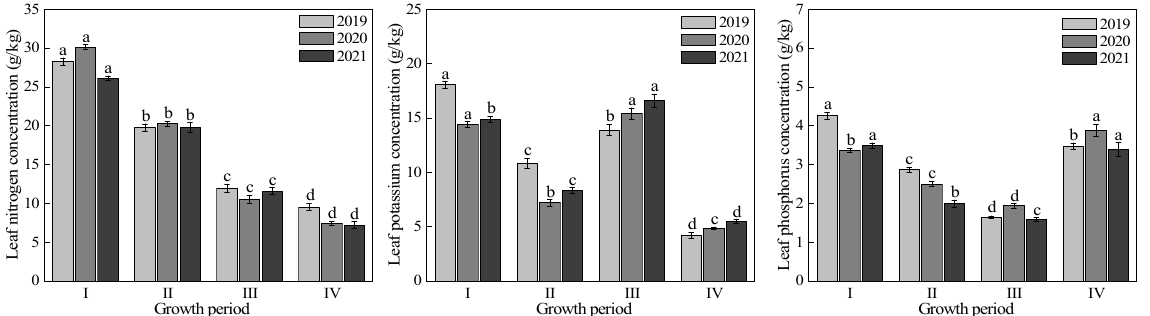
Figure 3. Variations in the LNC, LKC and LPC values (different small letters indicate significant difference at 0.05 level) at different grape growth stages (I, II, III and IV represent the new shoot growth stage, flowering stage, fruit expansion stage and veraison and maturity stage, respectively).